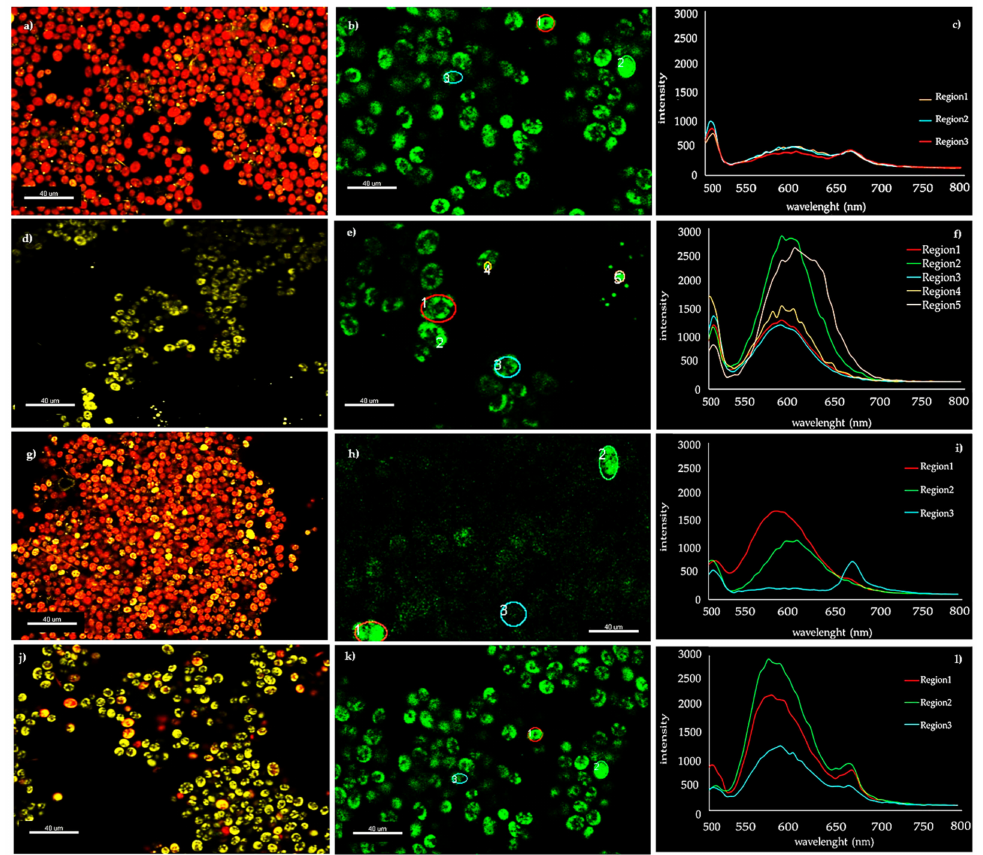
Figure 4. Confocal laser scanning microscope (CLSM) observations of Desmodesmus abundans. ( a – c ) cells grown in BBM + N / L 120 ; ( d – f ) cells grown in BBM-N / L 120 ; ( g – i ) cells grown in BBM + N / L 200 ; ( j – l ) cells grown in BBM-N / L 200 . Colored circles in ( b , e , h , k ) represent the regions of interest (ROI) of interest (from 1 to 5) studied by spectral analyses in the scan visible region ( c , f , i , l